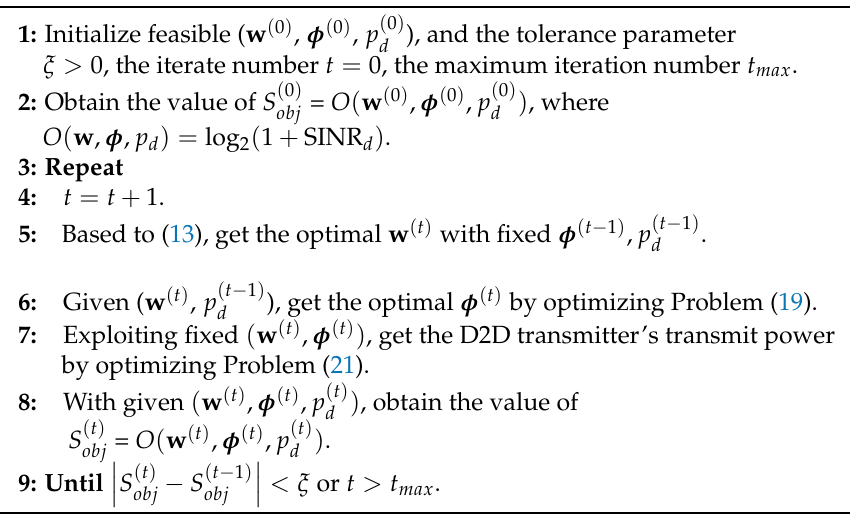
Algorithm 1 Proposed algorithm for data rate maximization